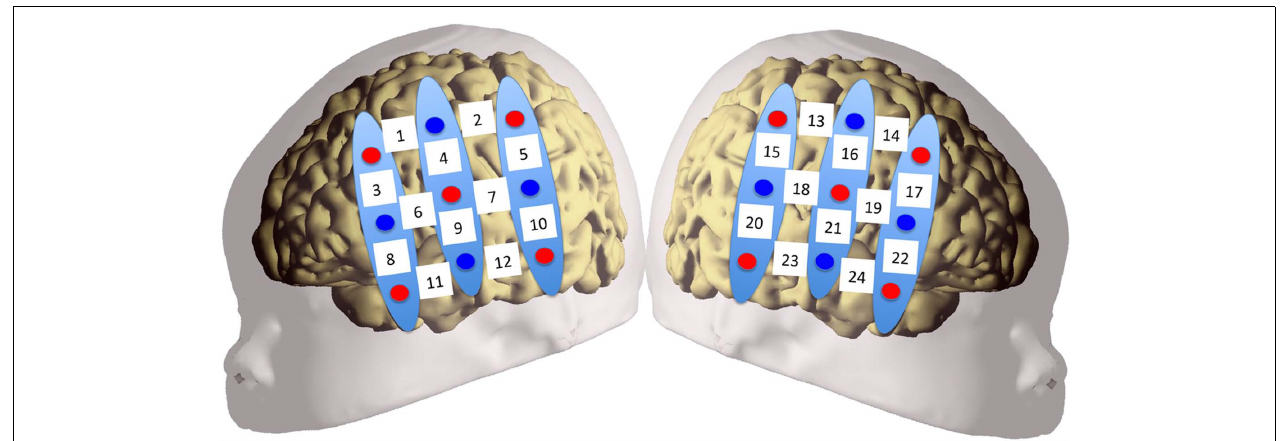
vertex. Channels 1–12 were placed over the left hemisphere, while channels 13–24 were placed over the right. Probes were placed so that the bottom-most channels (11, 12 in LH; 23, 24 in RH) ideally nestled above the infant’s ear.